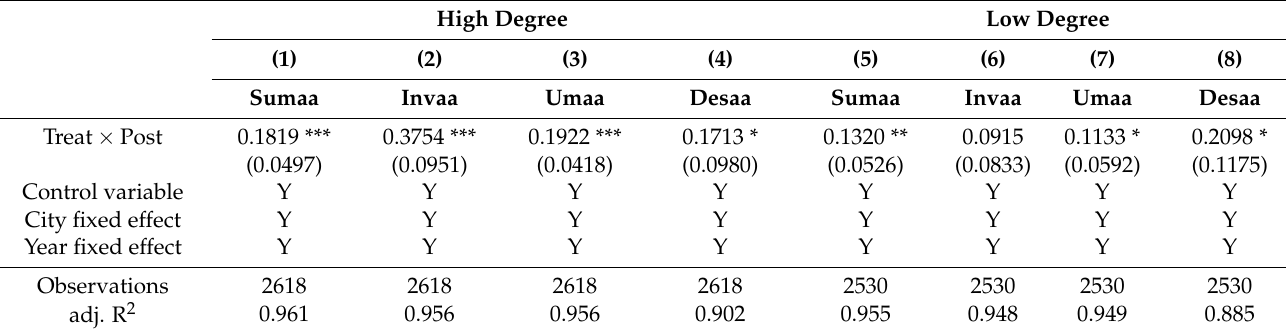
Table 11. Return results of intellectual property